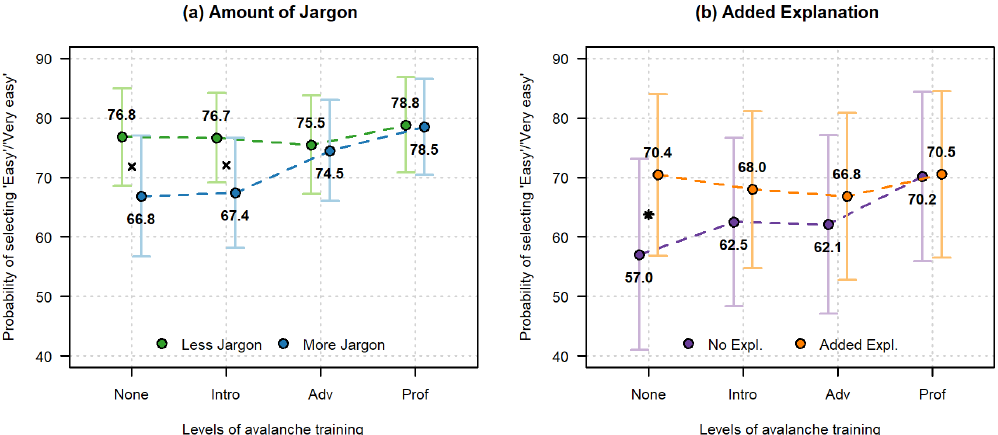
Figure 6. Estimated marginal probabilities for selecting easy or very easy for understandability of the statement as a function of (a) the interaction effect of avalanche training and amount of jargon and (b) the interaction effect of avalanche training and added explanation. Error bars represent 95% confidence intervals for probabilities calculated from the subsample for the particular parameter level. Significant post hoc pairwise comparisons are indicated with asterisks ( p values < 0.01), diagonal crosses (0.01 ≤ p values < 0.05), or horizontal crosses (0.05 ≤ p values < 0.1). Variable levels for calculations of estimated marginal probabilities: bulletin user type – type D, avalanche awareness